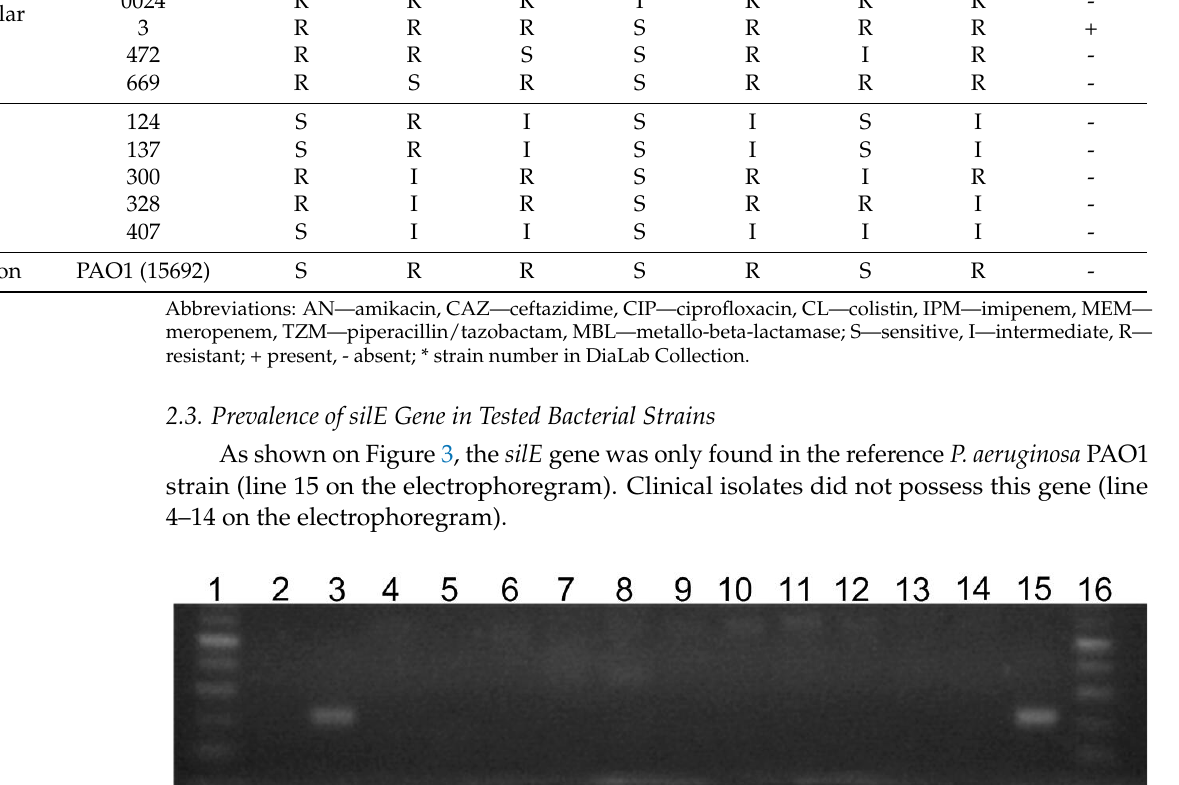
Table 2. Antibiotics’ susceptibility of P. aeruginosa strains.